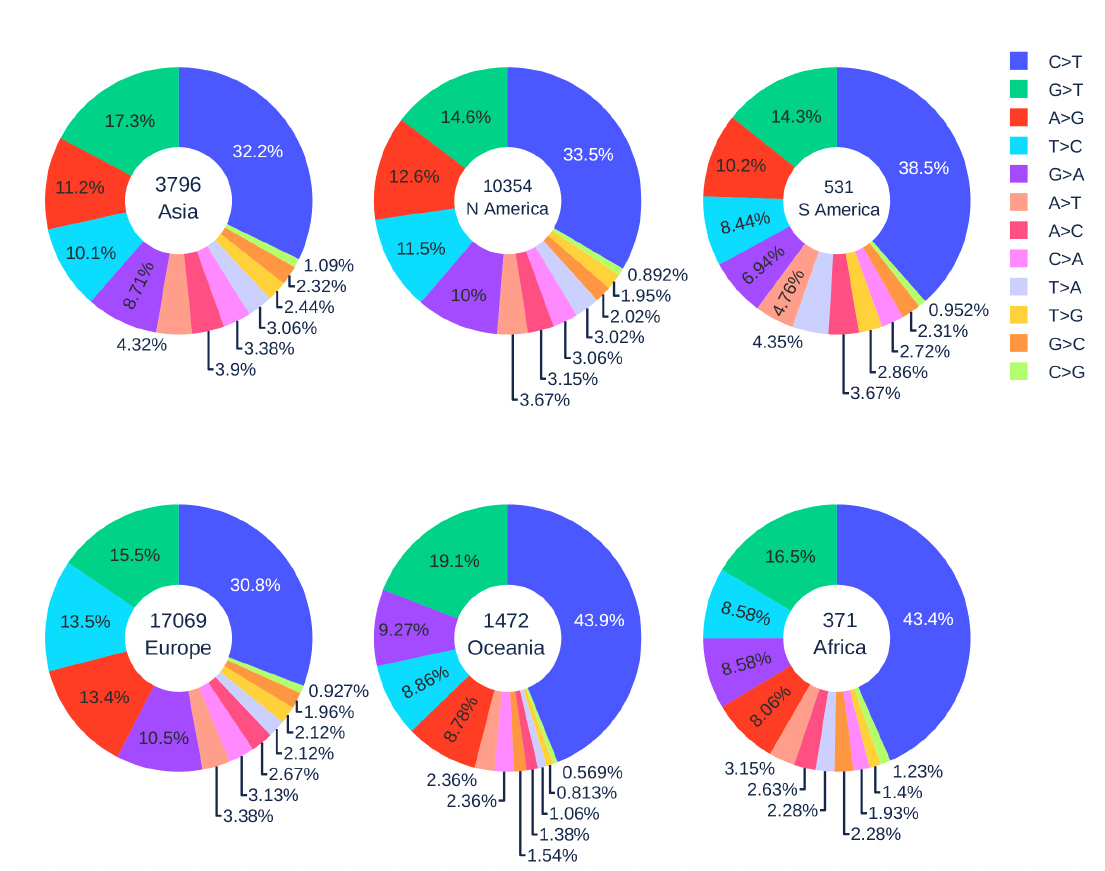
Figure 5. The distribution of 12 SNP types among unique mutations in the SARS-CoV-2 genome isolates in six continents. The text inside each circle represents the total number of records in each